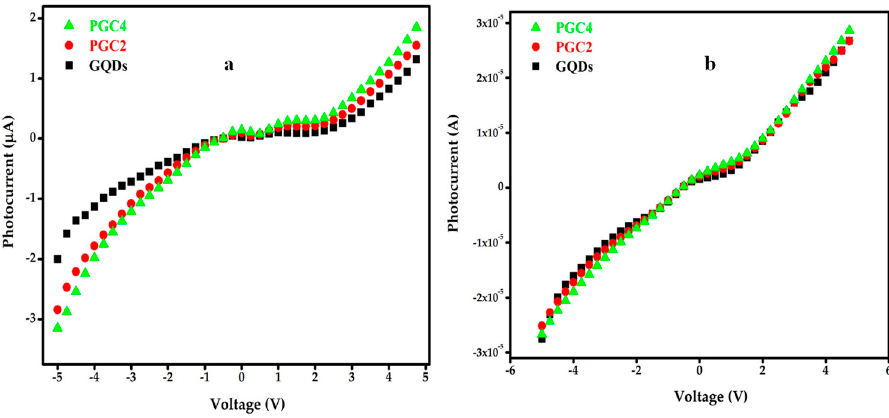
Figure 9. A comparison between the photocurrents of three photodetector devices under the illumi- nation of ( a ) 265 nm & ( b ) 355 nm UV light.